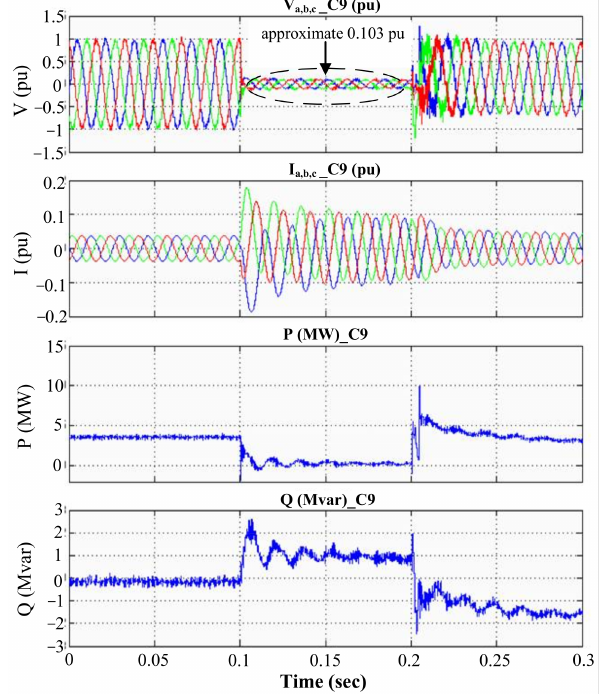
Figure 9. Responses of voltage, current, and real and reactive power on bus